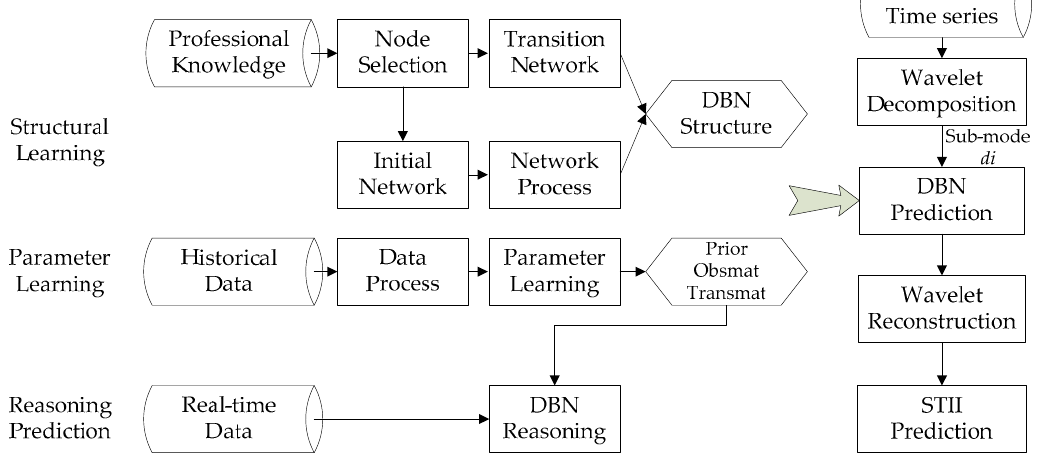
Figure 1. Technical structure of WA-DBN probabilistic prediction model.